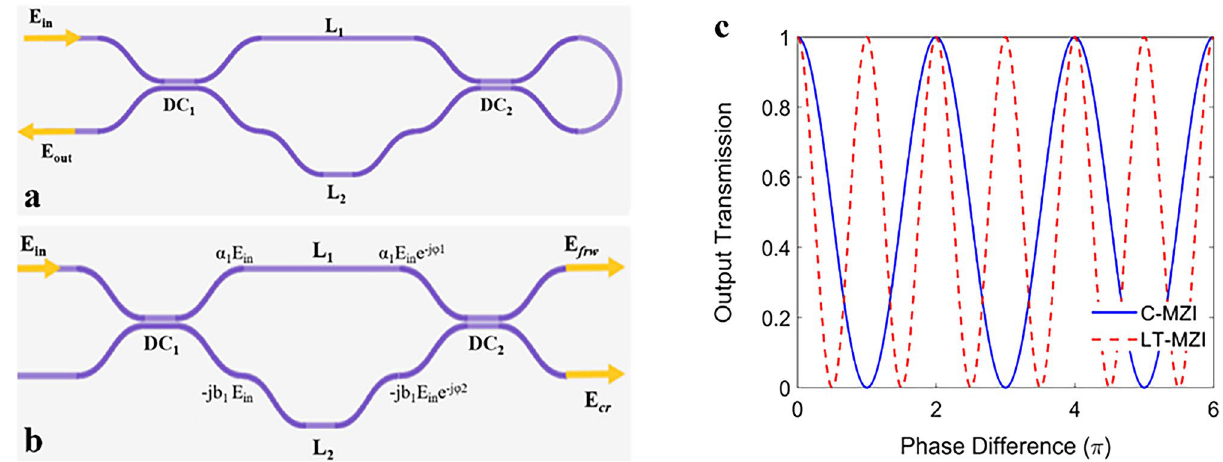
Figure 1. ( a ) Schematic of our proposed LT-aMZI, ( b ) schematic of C-aMZI DC c output transmission versus interferometer arms phase difference of both LT-MZI and C-MZI with 3-dB directional